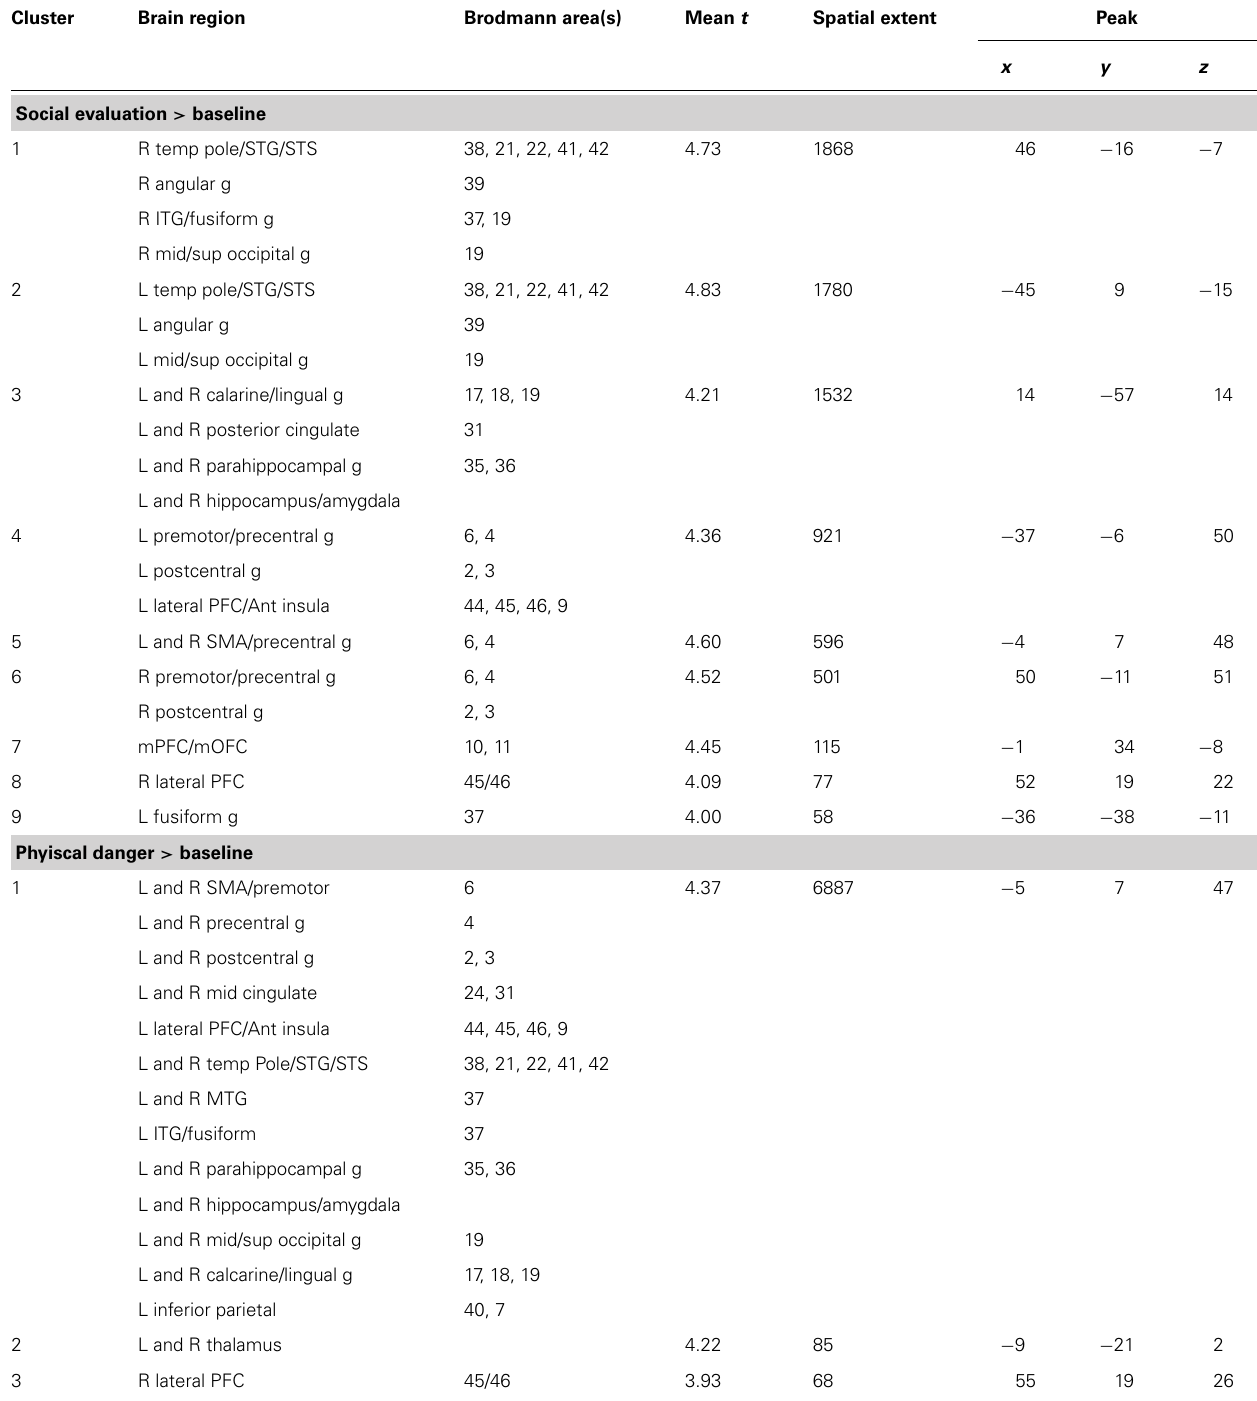
Table 2 | Social evaluation > baseline and physical danger > baseline